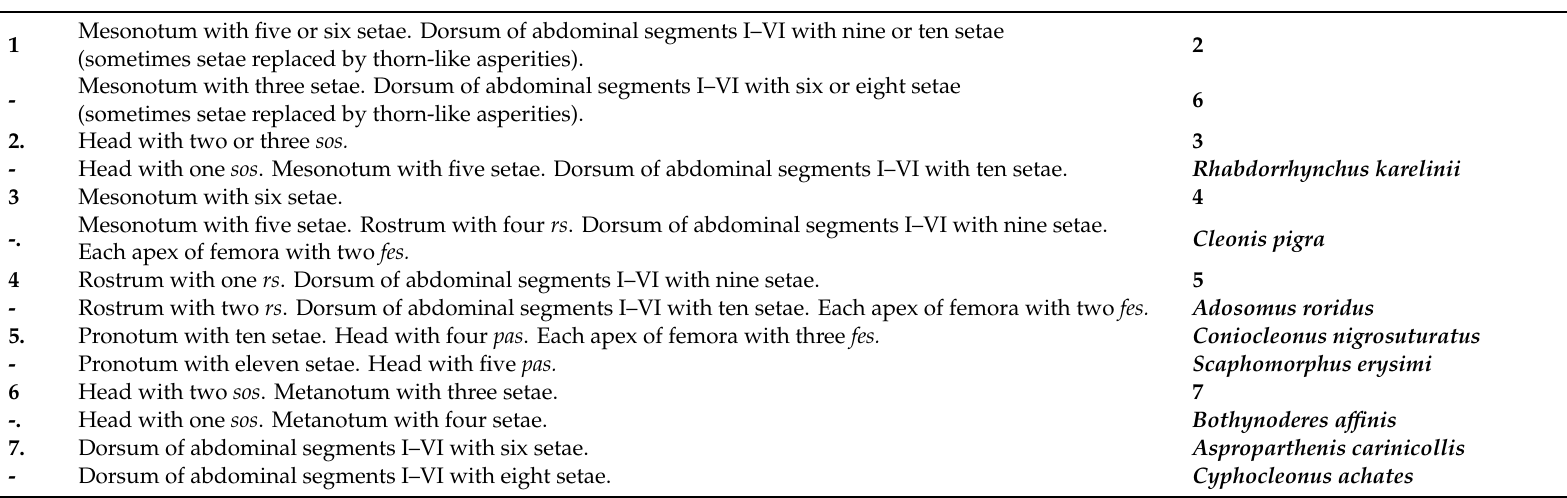
Table 2. Key to the Known Pupae of